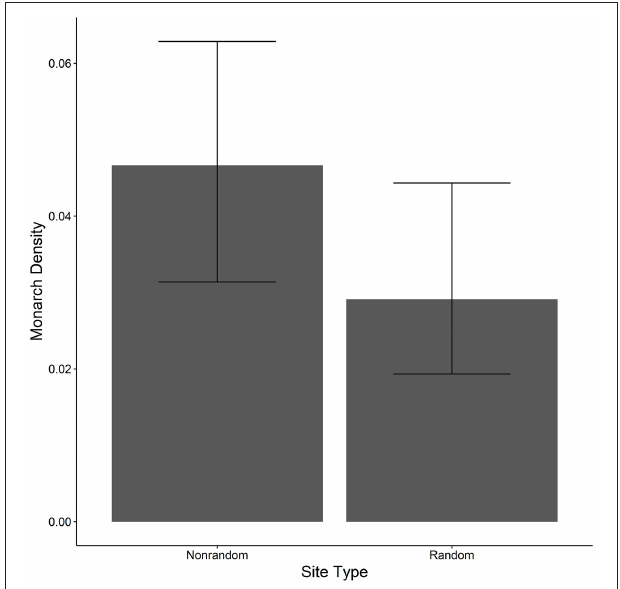
TABLE 2 | Model selection results comparing the influence of different fixed effects on monarch density in Iowa, 2006-2017. Fixed effects